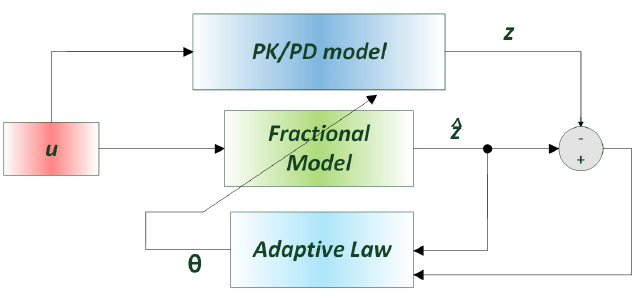
Figure 5. Identification scheme.